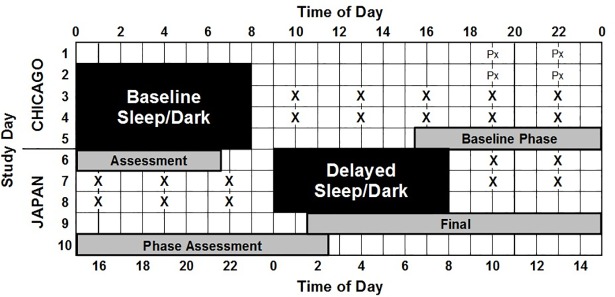
Protocol diagram.Time of day shown at the top is Chicago time and time of day shown on the bottom is Japan time (9-h earlier than Chicago time). Study day is shown on the left. Black shading shows timing of scheduled sleep periods. Schedules were individualized for each participant to best match their habitual sleep. This diagram shows the protocol for a participant on a 00:00–08:00 baseline sleep schedule. Days 1–5 were baseline during which participants remained on local, Chicago time (as indicated on the left). On days 7–9, the sleep schedule was shifted 9-h later (delayed), as though participants had traveled to Japan. The wall clocks in the bedrooms were changed to indicate the time in Japan. During baseline days the sleep schedule was aligned with each participant’s circadian rhythms, whereas during advanced days the sleep schedule was misaligned. “X” shows the timing of the Automated Neuropsychological Assessment Metrics (ANAM) performance battery and “Px” shows the timing of practice ANAM tests. Tests were given relative to each participants scheduled sleep times; 2 h after waking, and then every 3 h with a total of five tests per day. Light grey shading shows the timing of circadian phase assessments, during which the dim light melatonin onset (DLMO) was assessed.